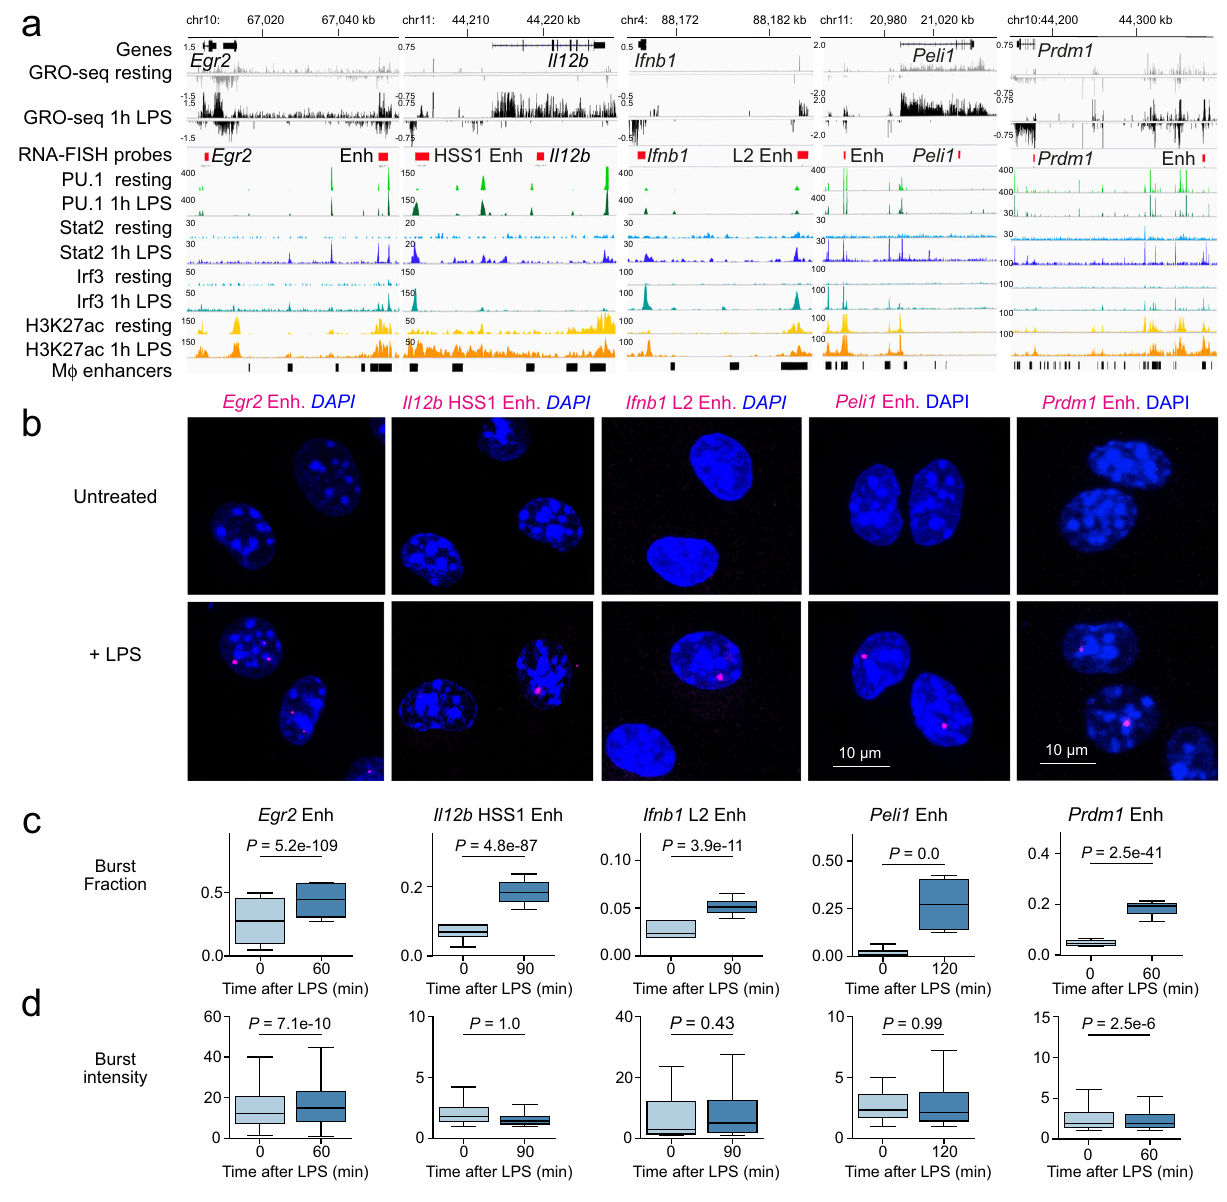
Fig. 3 Inducible enhancer activation is linked to increased eRNA burst fractions. a Inducible enhancers associated with inducible genes in macrophages with GRO-seq reads from resting and 1 h LPS-activated macrophages, ChIP-seq for PU.1 and STAT2, IRF3 and H3K27ac. Macrophage enhancers were de fi ned previously 31 . The positions of smRNA-FISH probes are magenta. b smRNA-FISH Images of eRNA bursts in untreated and LPS-activated macrophages with probes for the Egr2 enhancer (0 and 60 min LPS), the Il12b HSS1 and Ifnb1 L2 (0 and 90 min LPS), and the Peli1 enhancer (0 and 120 min LPS). smRNA-FISH probes are in magenta. At least three independent biological replicates per gene and condition, n = 64,682 cells. c eRNA burst fractions in resting and LPS-activated macrophages. At least three independent biological replicates per gene and condition, n = 64682 cells. d eRNA burst intensities in resting and LPS-activated macrophages. P values were determined by a two-sided Tukey HSD test (ANOVA design formula ∼ Sample + Replicate) and adjusted for multiple testing. At least three independent biological replicates per gene and condition, n = 64,682